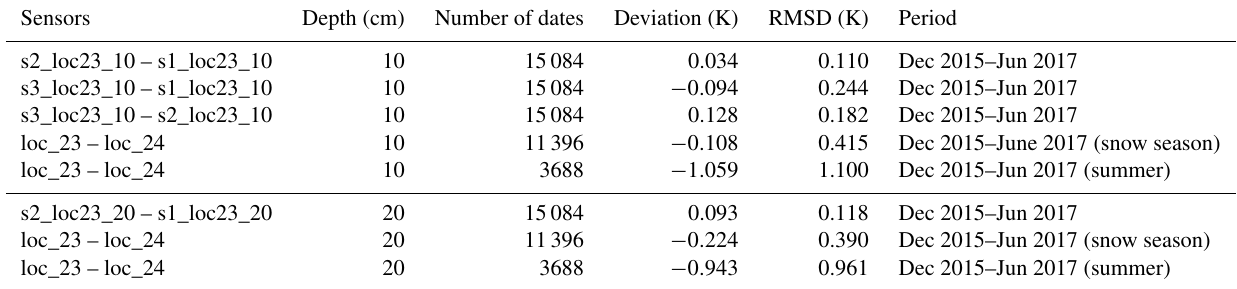
Table 7. Statistics of the comparisons between the different soil temperature measurements represented in Fig. 10. Sensors Depth (cm) Number of dates Deviation